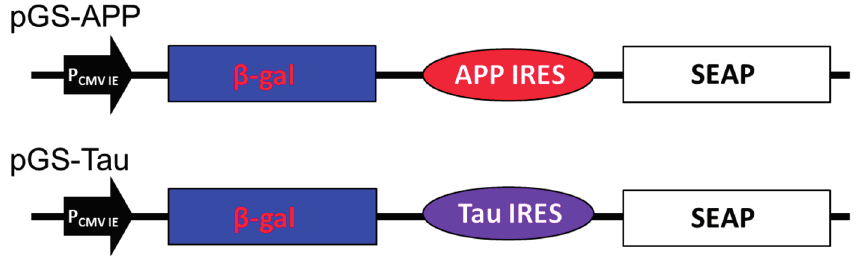
Figure 1. Construct of pGS-APP and pGS-Tau. The bi-cistronic vectors contain the genes for beta-galactosidase ( β -Gal) and secretory alkaline phosphatase (SEAP), IRES element from the APP or the Tau genes, APP IRES and Tau IRES, respectively. P CMV IE is the promoter of human cytomegavirus immediately early